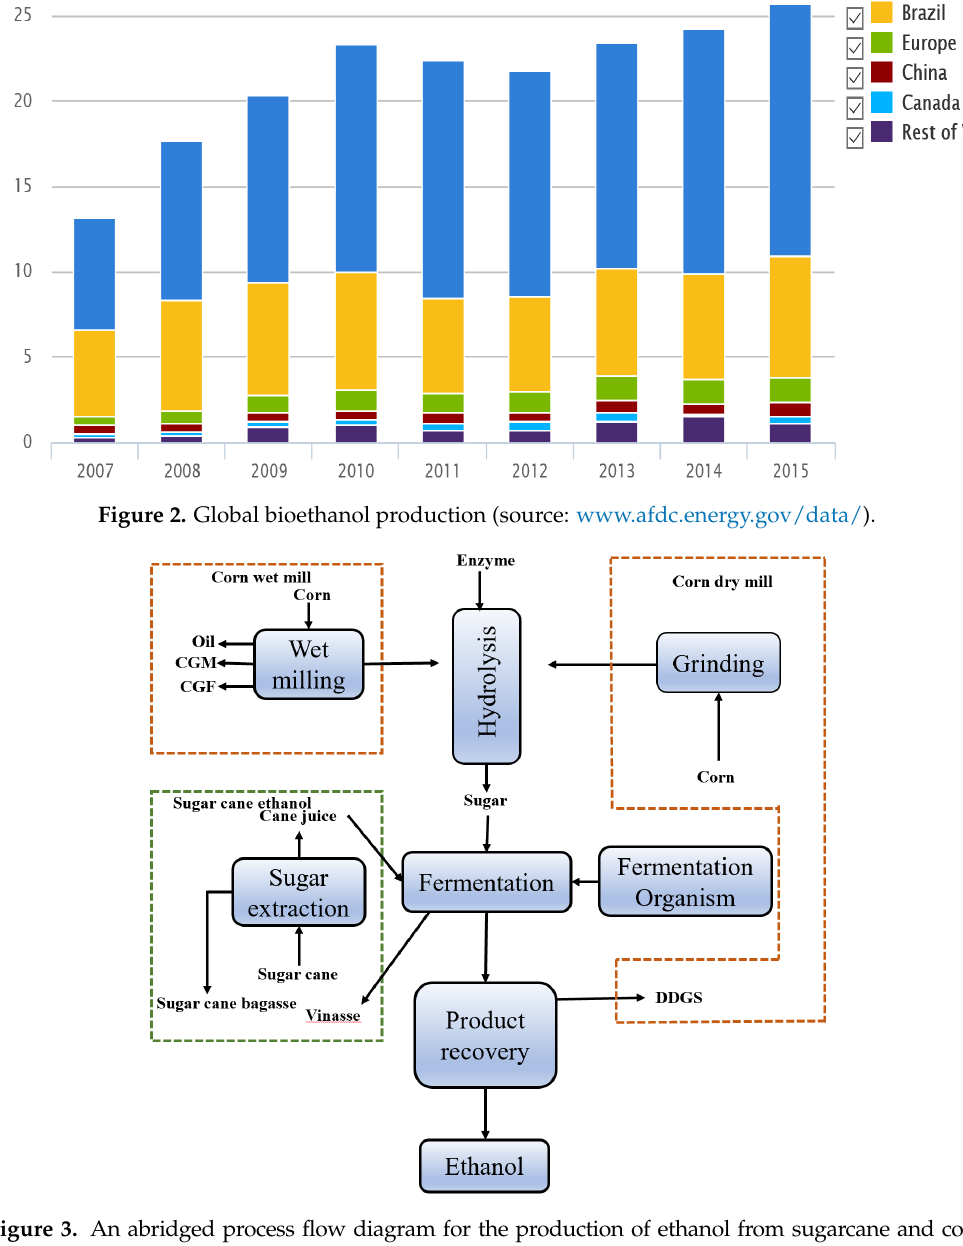
Figure 3. An abridged process flow diagram for the production of ethanol from sugarcane and corn. Adapted from [27]. They both have similar fermentation and ethanol recovery operations but use different approaches to release sugars and generate different co-products. Sugar can be directly extracted from sugarcane, and the residual bagasse is used as a boiler fuel to provide much of the energy for the extraction and ethanol production and recovery operations. In a corn dry mill, corn is ground, and enzymes and heat are added to hydrolyze starch to sugars for conversion to ethanol, while the oil, protein, and fiber in corn are recovered after fermentation as an animal feed known as DDGS. Wet mills first fractionate corn to separate corn oil, corn gluten meal (CGM), and corn gluten feed (CGF) to capture value for food and animal feed, and the starch can then be hydrolyzed to sugars for fermentation to ethanol.